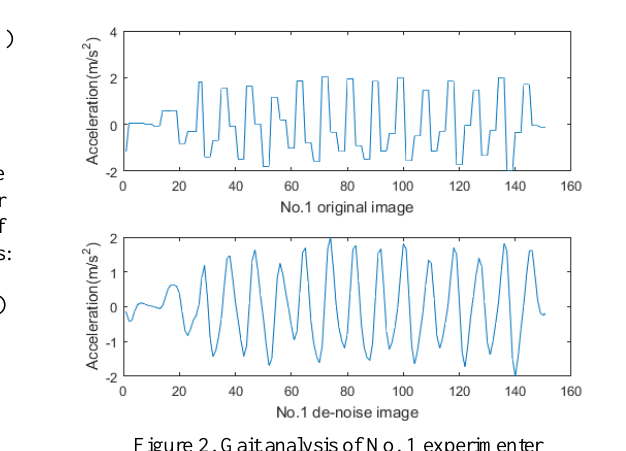
Figure 2. Gait analysis of No. 1 experimenter No. 1 experimenter’s peak detection is 15 steps, which belong to accurate detection. No. 2 experimenter went straight and then made a turn for 22 steps in total, as shown in Figure 3.